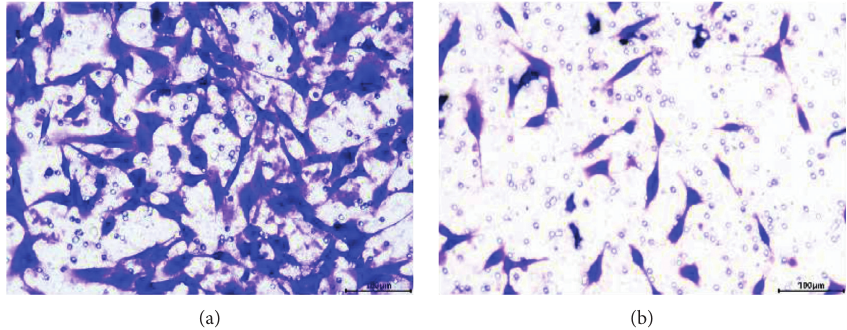
Figure 11: Effects of ADD3-AS1 overexpression on PTC-UC3 cells invasion. Scale: 100 μ m. (a) Control. (b)